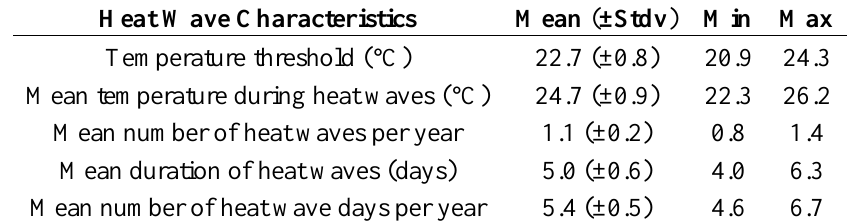
Table 2. Meteorological heat wave characteristics for Germany during 2001–2010: mean (± standard deviation), minimum, and maximum of the 19 regions.